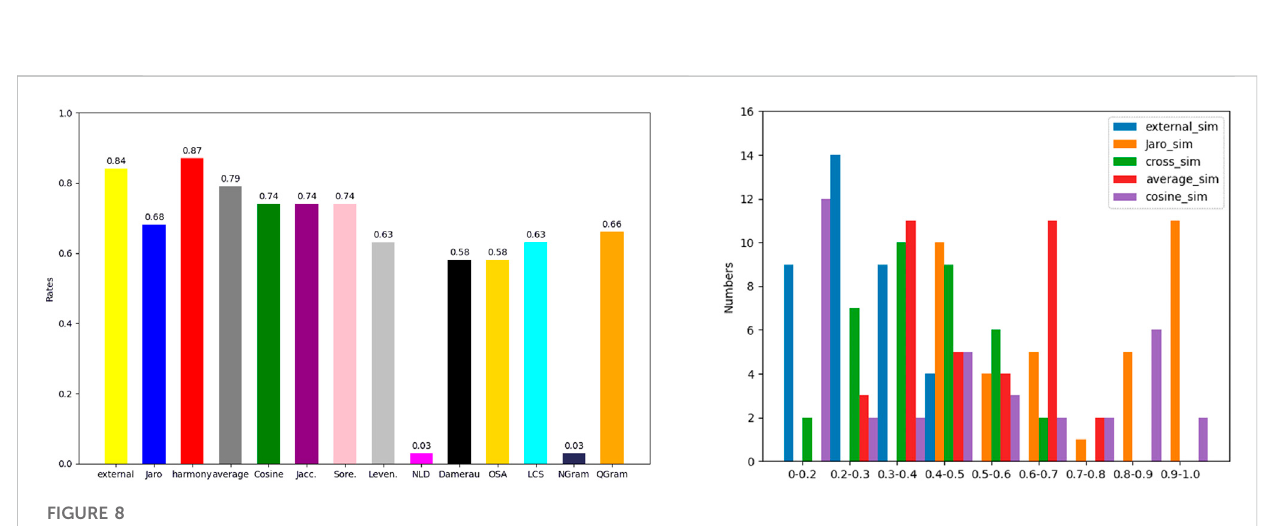
FIGURE 8 Correction rates and intervals based on different similarity